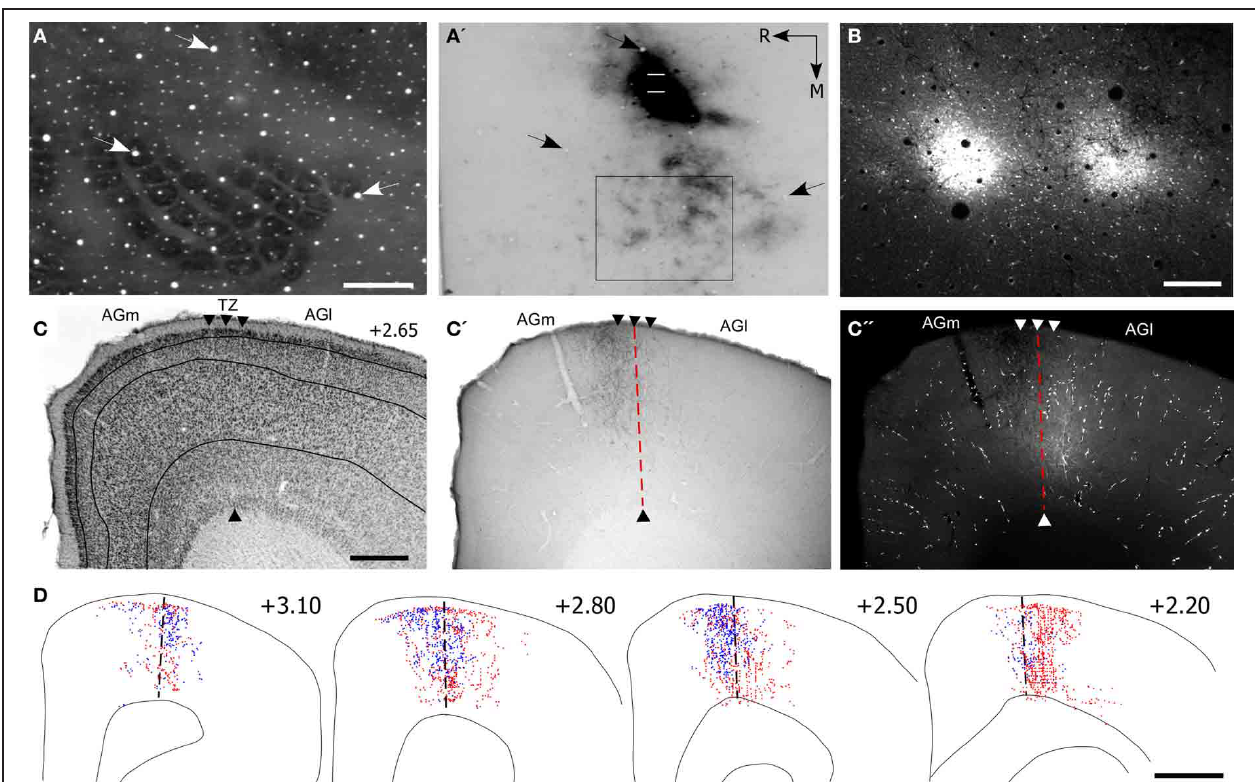
cortex. (C) Cytoarchitecture depicting the transition zone (arrowheads). (C (cid:2) ,C (cid:2)(cid:2) ) Adjacent sections depicting the terminal projections from SII and SI with respect to the transition zone (dashed line). (D) Reconstructions of SI (red) and SII (blue) labeled terminals throughout the rostrocaudal extent of MI. Scale bar = 500 μ m in (A,C) ; 250 μ m in (B) ; 1mm in (D)